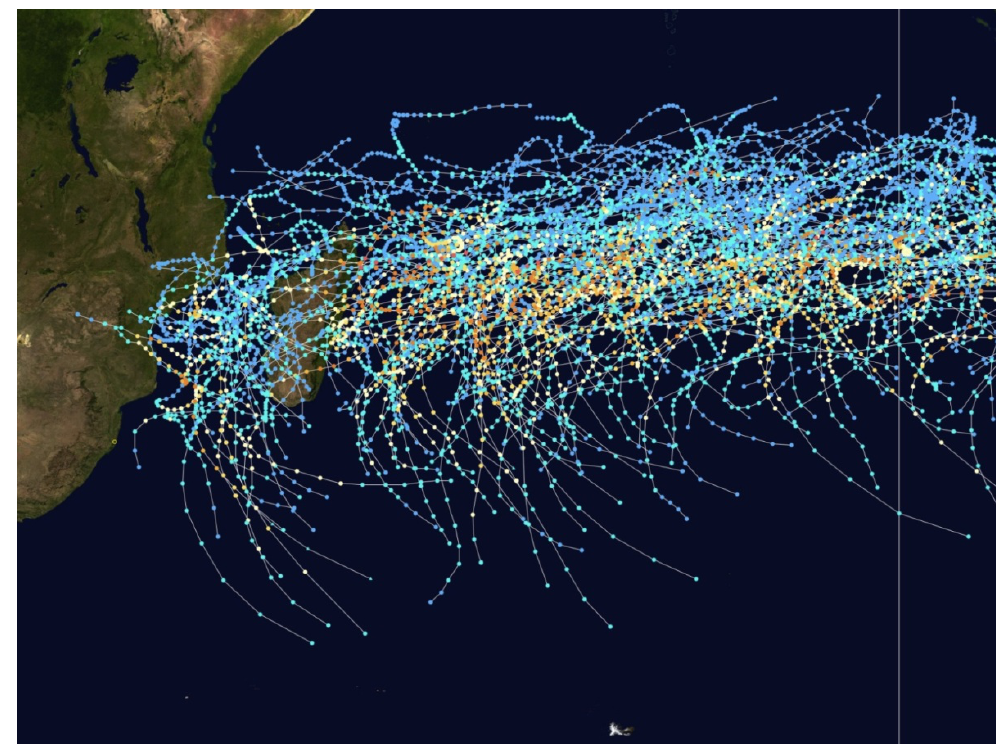
Figure 2. Tracks of all tropical cyclones in the Southwest Indian Ocean from 1980 to 2005. 90° E longitude is marked (vertical blue line) as this is the eastern boundary of the basin. The points show the locations of the storms at six-hourly intervals (Source: Wikimedia Commons [26]).